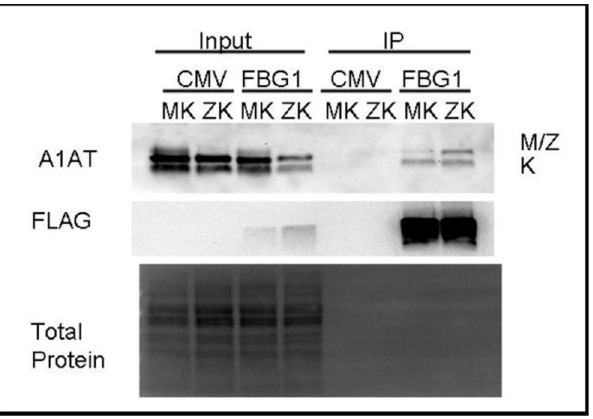
Fig 2. FBG1 immunoprecipitates normal and mutant versions of A1AT. Upper panel: the input came from the total cell lysate of Hepa1-6 cells co-transfected with pCMV or FBG1, and the indicated mixes of A1AT variants. FLAG co-immunoprecipitation (IP) lanes were probed with anti-A1AT that recognizes the M, Z, and K forms of A1AT. Middle panel: anti-FLAG antibody detects FLAG-FBG1, indicating successful transfection of FLAG-FBG1 in cells. Bottom panel: total protein indicates roughly equal loading of protein. The lack of total protein staining in the IP lanes is expected, as the amount of protein pulled down in an IP is below detection